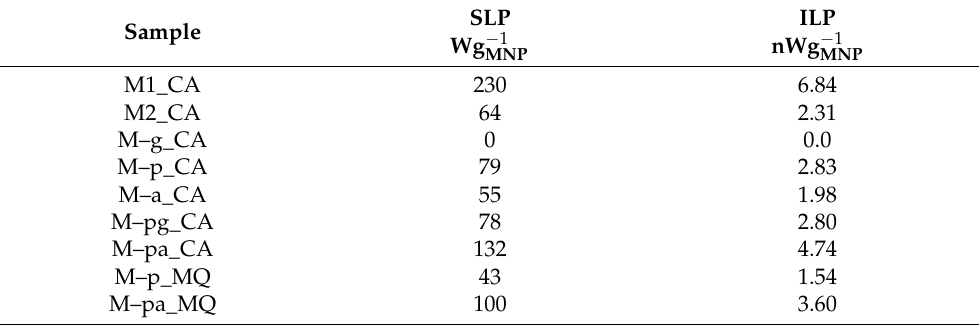
Figure 12. Temperature evolution during applied ac magnetic field for samples: ( a ) M–a_CA and ( b ) M–p_CA, showing good reproducibility of the results and the good quality of the fit. Table 10. Specific loss power (SLP) determined for the stable MNP suspensions and the corresponding intrinsic loss power